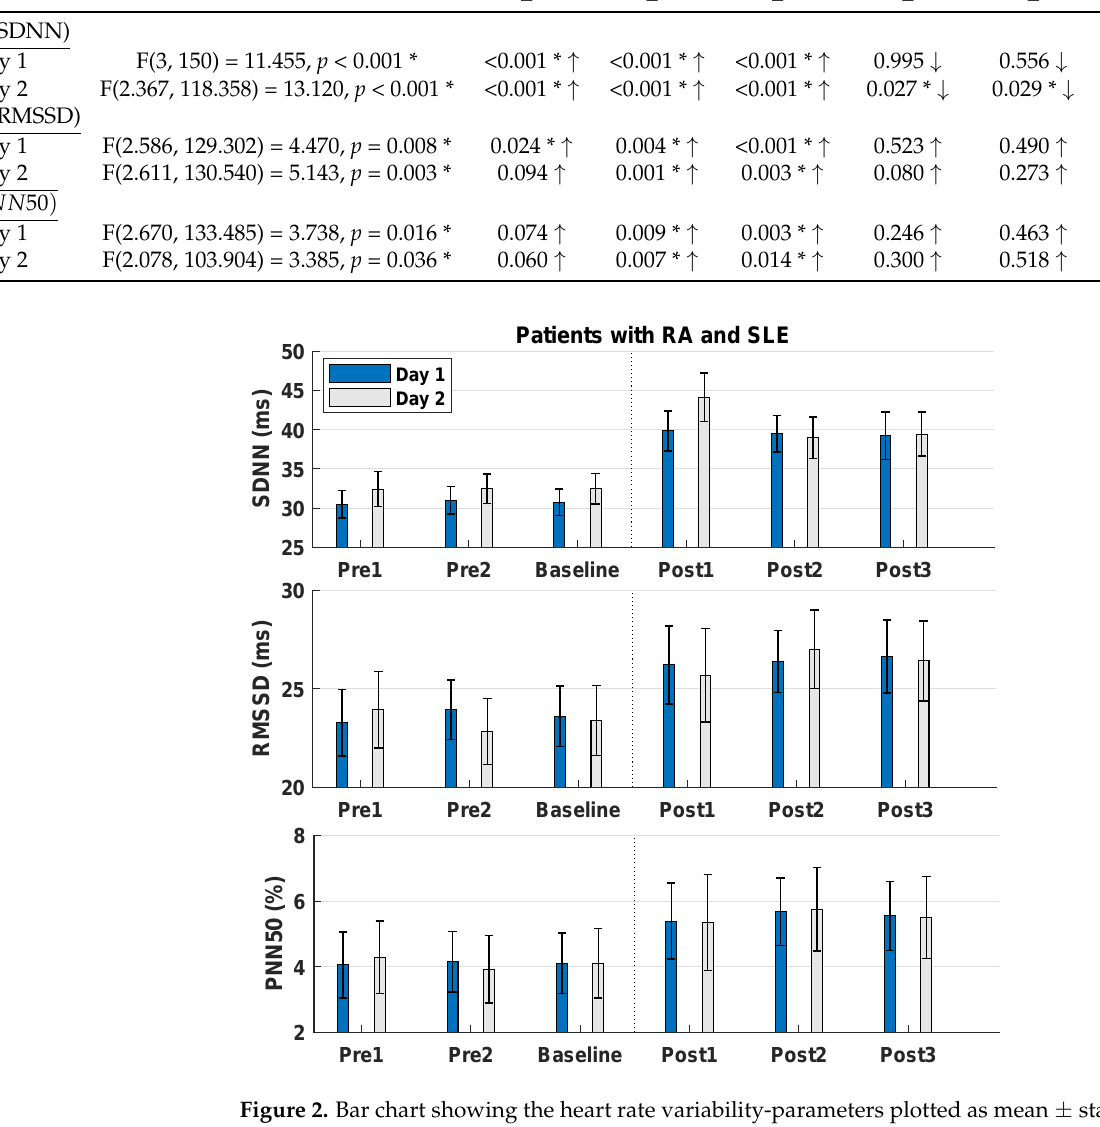
Figure 2. Bar chart showing the heart rate variability-parameters plotted as mean ± standard error in patients with RA and SLE. RA: Rheumatoid Arthritis. SLE: Systemic Lupus Erythematosus. SDNN: The standard deviation of the R-R intervals. RMSSD: The root mean square of successive R-R intervals. PNN50: The proportion of NN50 (pairs of successive R-R intervals that differ more than 50 milliseconds) divided by the total number of R-R intervals. Post1, post2, and post3 were performed at 0–5, 12.5–17.5, and 25–30 min after the deep breathing intervention,